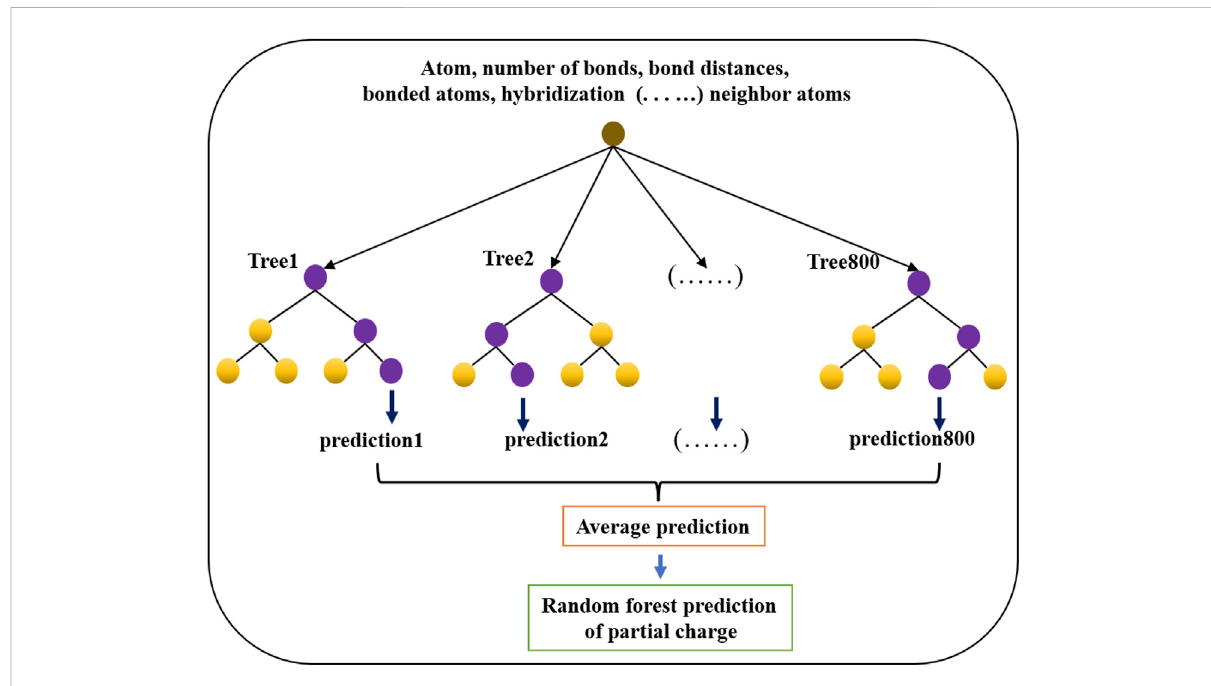
FIGURE 4 Architecture of the random forest regression model used to predict partial charges for atoms in drug-like small